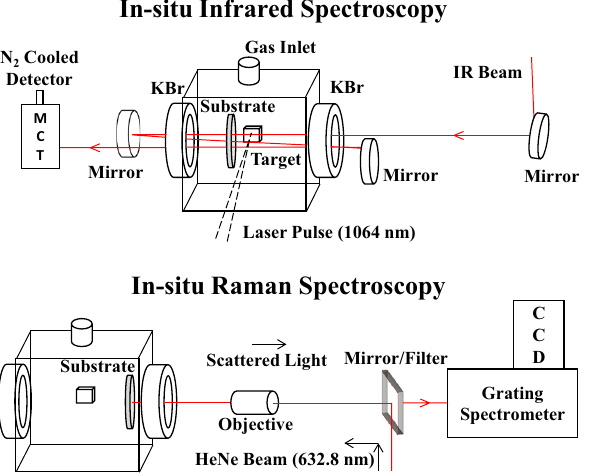
Figure 1. Schematic of the ablation chamber and configurations with in-situ infrared (top) and Raman (bottom) spectroscopies. Shown is a 2.75 ″ CF 6-way cube with two KBr window flanges and one gas inlet flange. The chamber also consists of one sapphire window flange (for the laser pulse), one translation arm flange (to hold the uranium target), and one blank flange (as a supporting base) not shown for clarity. The total length is ~ 6 inches along the IR beam axis. Particulates formed during the ablation process are collected on a KBr substrate positioned close to the ablation plume. Infrared light, guided by gold-coated focusing mirrors, makes multiple passes through the substrate to obtain an IR absorption spectrum. Tilting the chamber moves the KBr substrate towards the external window allowing for in-situ Raman spectra to be